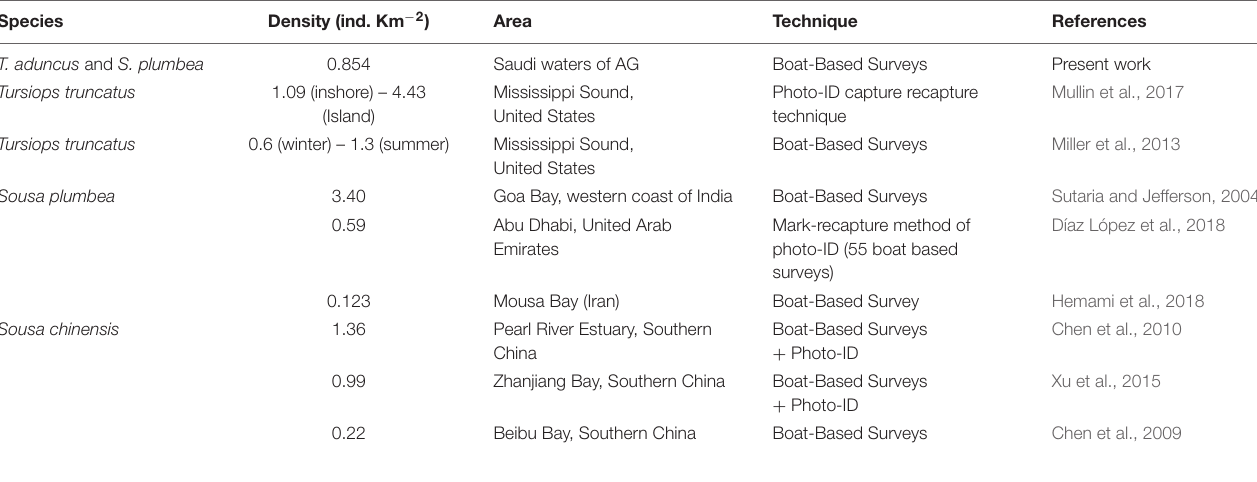
TABLE 6 | Comparison of the dolphin density (both bottlenose, T. aduncus , and humpback, S. plumbea , dolphins) in the Saudi waters of the Arabian Gulf with those recorded with the same and other congeneric species in other regions.